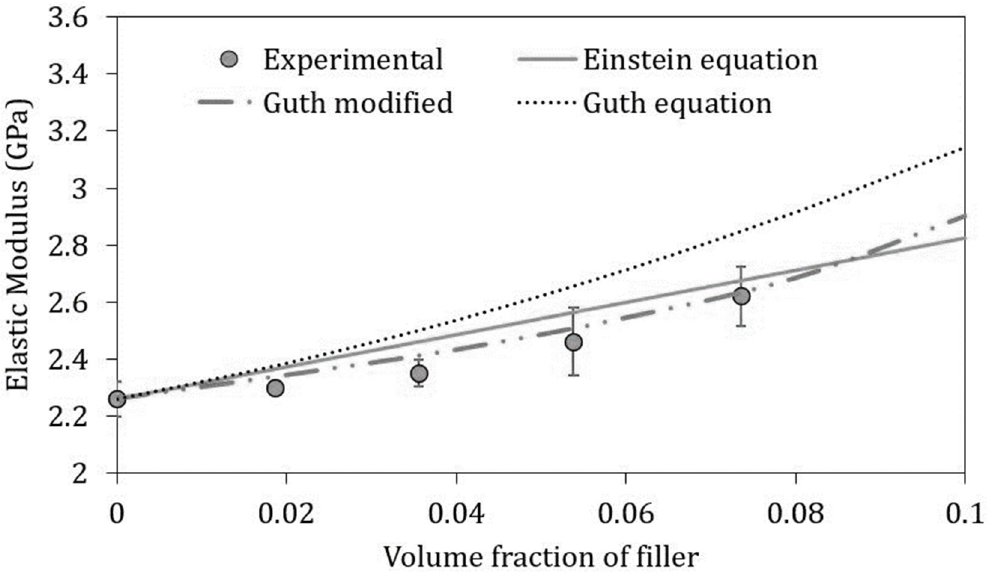
Figure 6. Comparison between the experimental elastic moduli of the PLA / PBAT biocomposites with mussel shells and the values predicted according to the different equations reported in the legend.